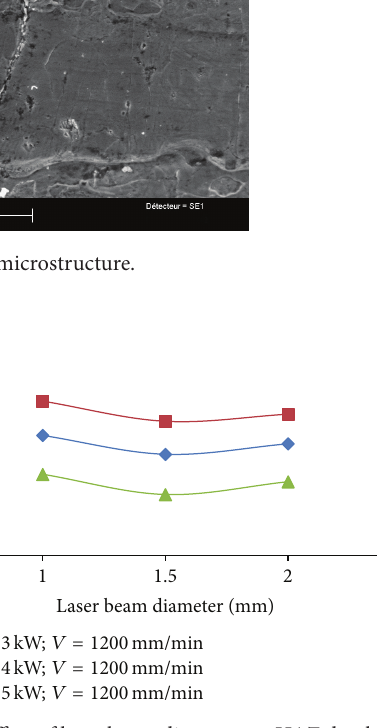
Figure 8: Effect of laser beam diameter on HAZ depth.